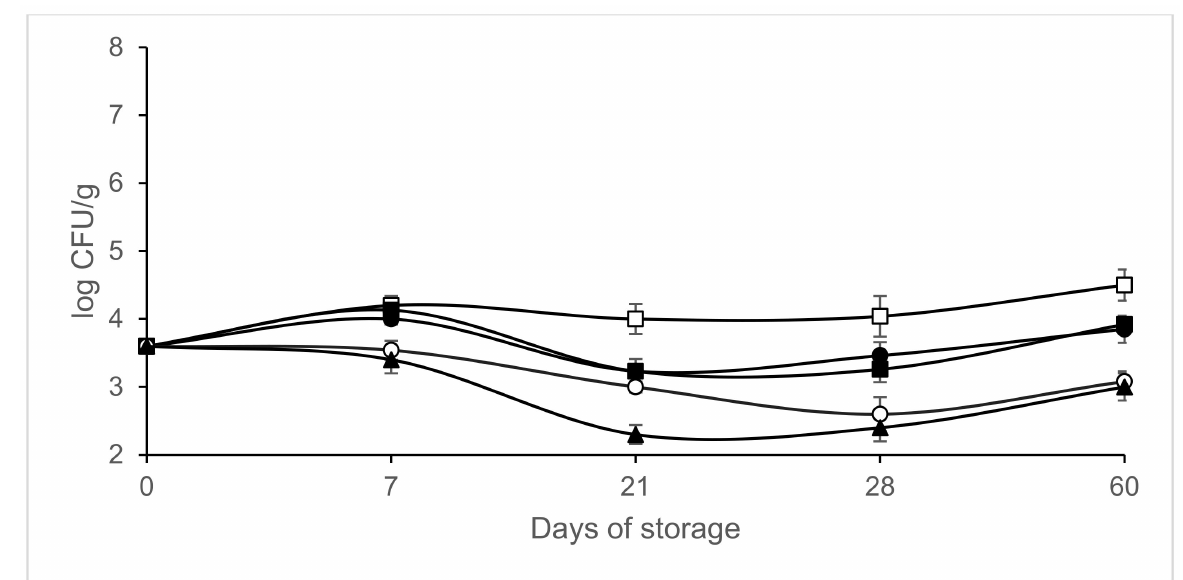
Figure 5. Effect of packaging conditions on yeast counts in inoculated sliced chorizo packaged in modified atmospheres. Packaging conditions: Air ( (cid:3) ), 100% Nitrogen ( (cid:4) ), Vacuum ( • ), 20% CO 2/ 80% N 2 (